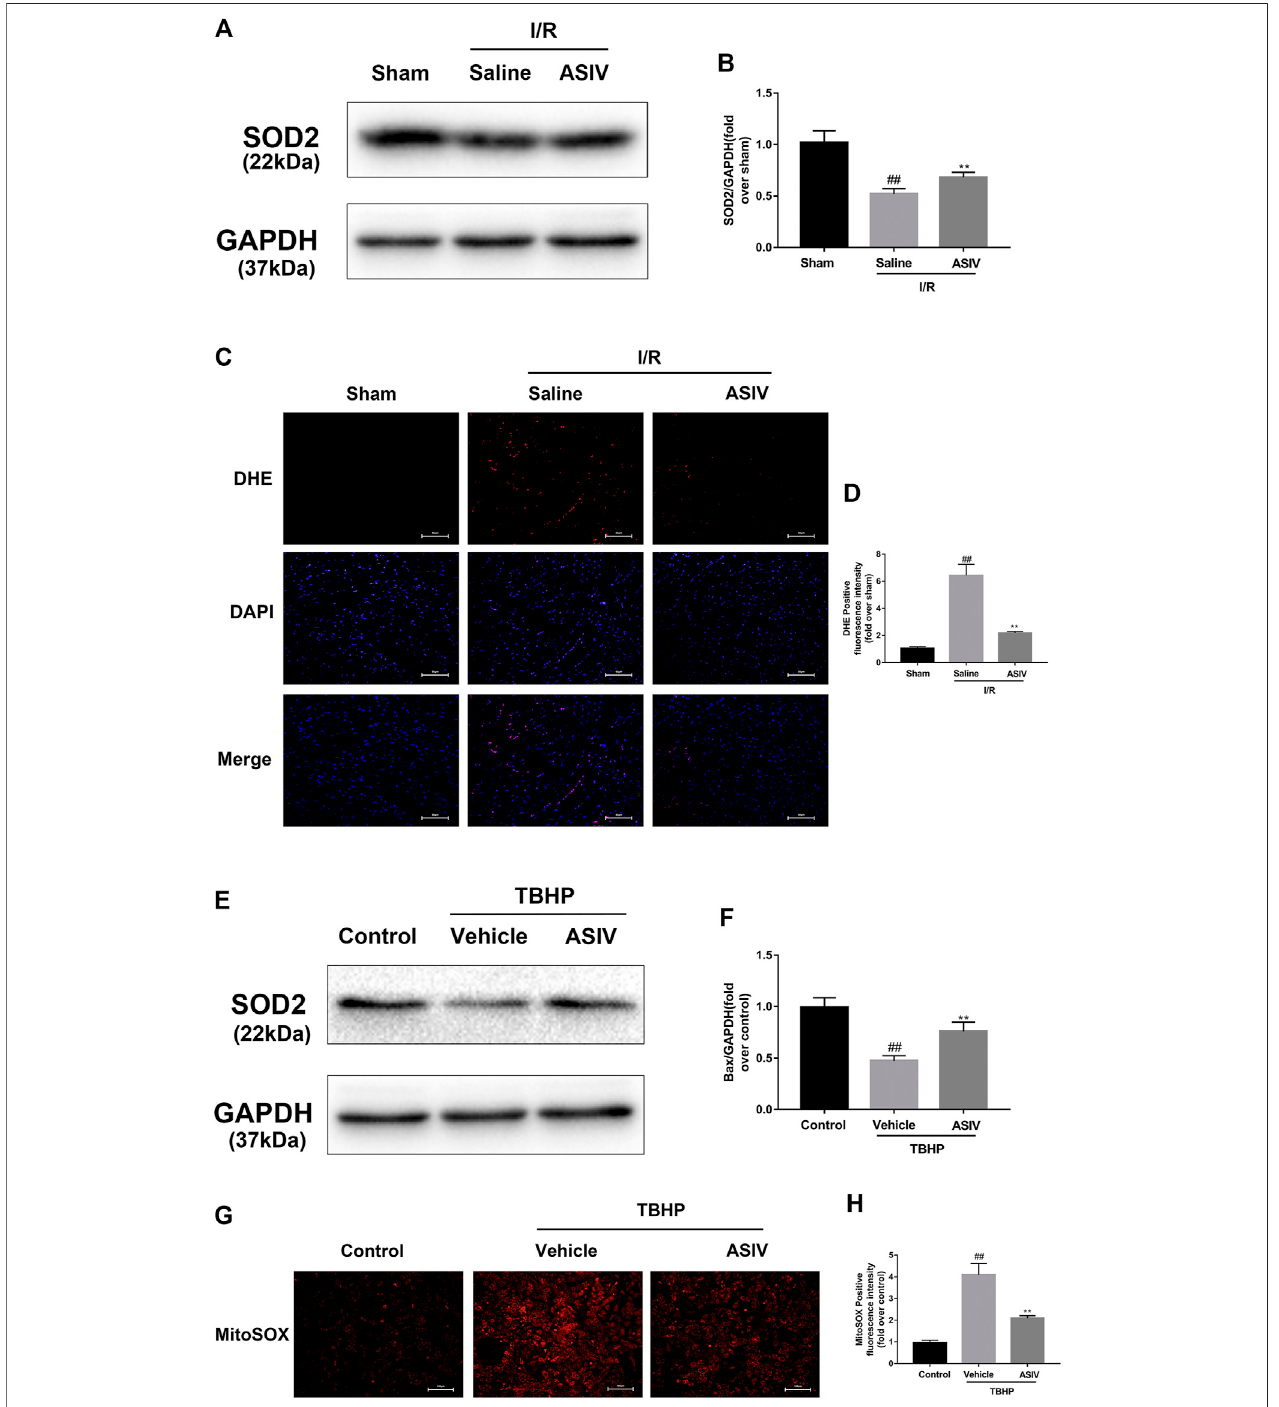
(cid:129) − FIGURE 6 | ASIV decreased I/R-caused O2 accumulation. Mice were treated with ASIV (20 mg/kg; i.p.) during reperfusion, (A, B) protein expression levels of (cid:129) − SOD2wereanalyzedbywesternblot. (C,D) O2 inmyocardiumwasdetectedbyDHEstaining.Scalebar:50 µmH9C2cellsweretreatedwithASIVandsufferedfrom (cid:129) − TBHP injury, (E, F) protein expression levels of SOD2 were analyzed by western blot. (G, H) O2 in H9C2 cells was detected by MitoSox Red staining. Scale bar: 100 µm n (cid:2) 6.Valuesareexpressedasthemeans ± SD.# p < 0.05comparedwiththeshamorcontrolgroup,* p < 0.05comparedwiththeI/RorTBHPgroup(each test was repeated three